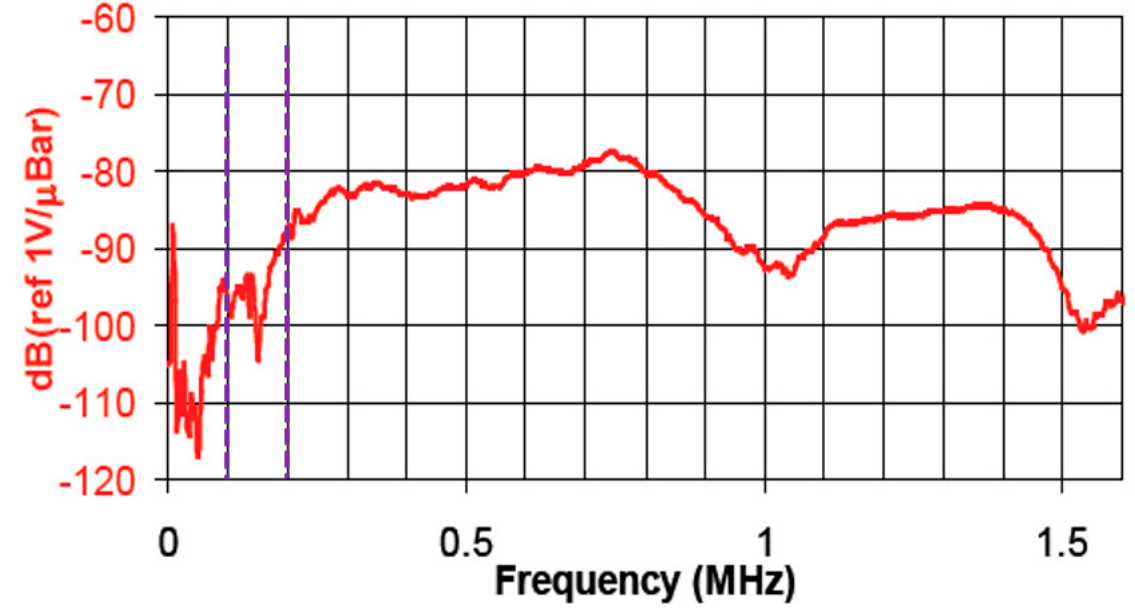
Figure 6. Frequency response of S9225 sensor from the manufacturer.